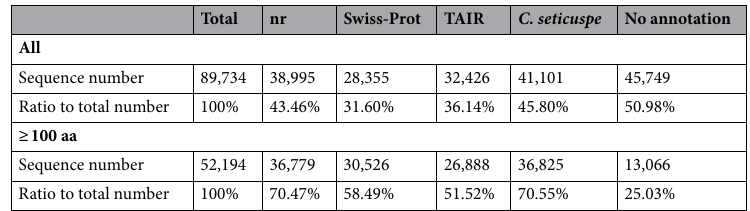
Table 4. Summary of the homology search of amino acid sequences from Cmsa representative mRNAs.